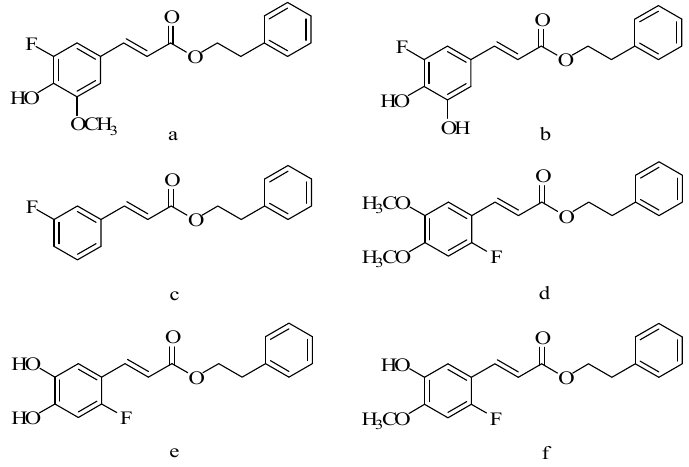
Figure 15. The structure of fluorine substituted derivatives of